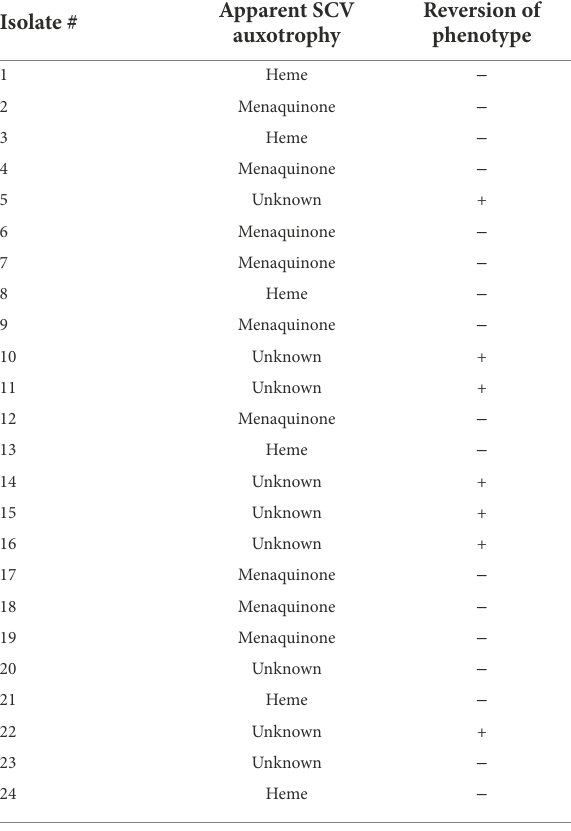
TABLE 1 Phenotypic assessment of stable, iron starvation-induced SCV isolates.